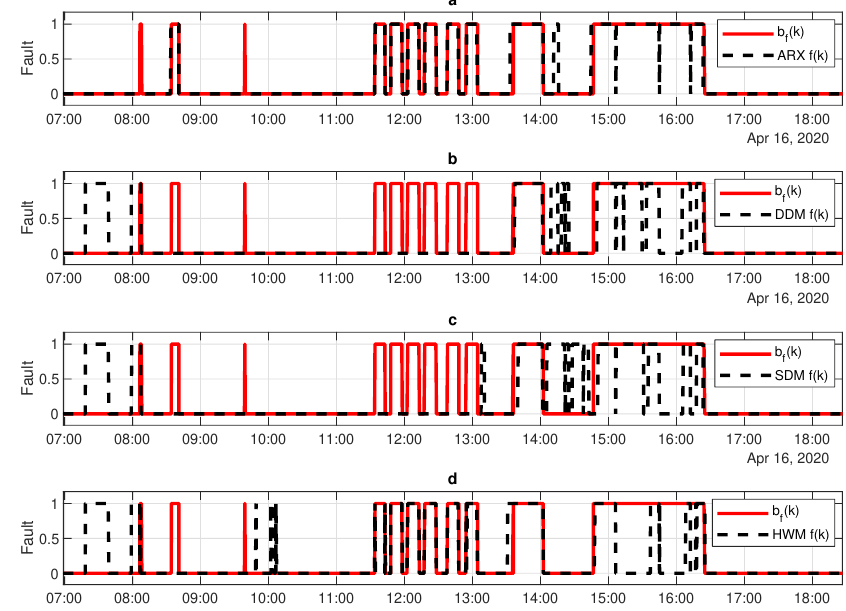
Figure 13: The proposed method consists in transmitting a frame using ⌈ α n cha ⌉ channel uses for the fi rst transmission attempt, with 0 < α ≤ 1 . In the event of a decoding error, incremental redundancy is transmitted 1 − α n cha ⌋ channel uses. making use of the rest of the available ⌊ ( )